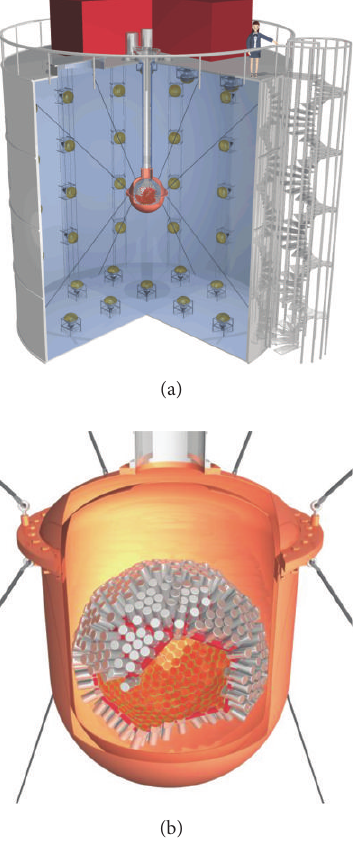
Figure 20: Schematic view of the full XMASS facility (a) and details of the inner detector (b) from which one can see the particular configuration of the hexagonal photomultiplier tubes. Taken from [183, 184].